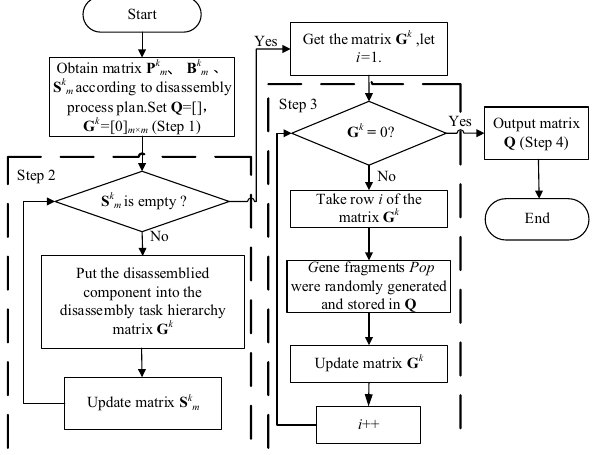
Figure 3. Chromosome acquisition flowchart.